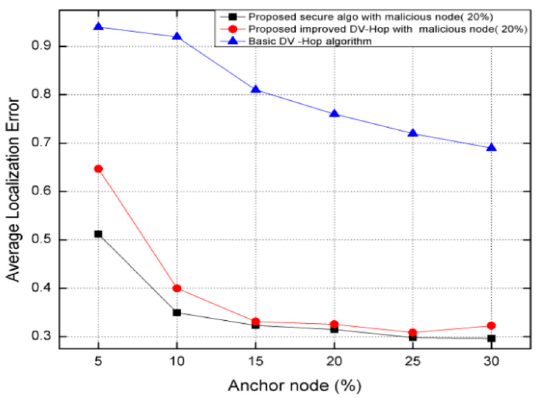
Figure 9. Localization error versus total number by ratio.